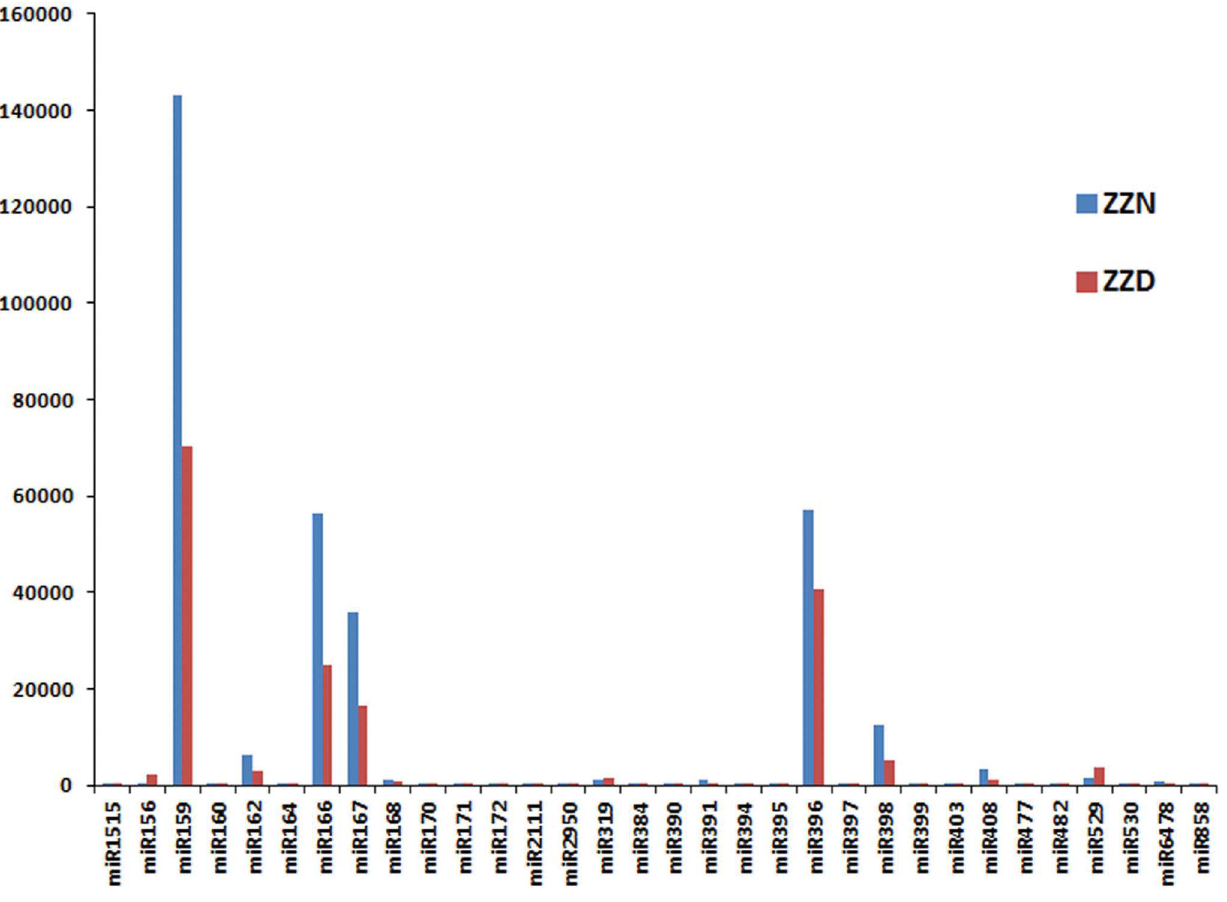
Fig 3. Number of reads for the conserved miRNA